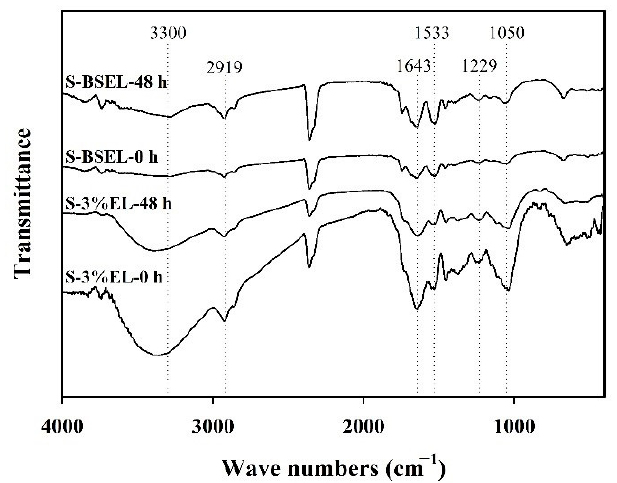
Figure 6. FTIR spectra of the solid-parts separated from the sterilized fermentation medium after inoculation of L. plantarum for the four samples: (1) solids of 3% EL in MRS at 0 h (S-3%EL-0 h), (2) solids of 3% EL in MRS at 48 h of fermentation (S-3%EL-48 h), (3) solids of 3% EL in black soymilk at 0 h (S-BSEL-0 h), and (4) solids of 3% EL in black soymilk at 48 h of fermentation (S-BSEL-48 h).